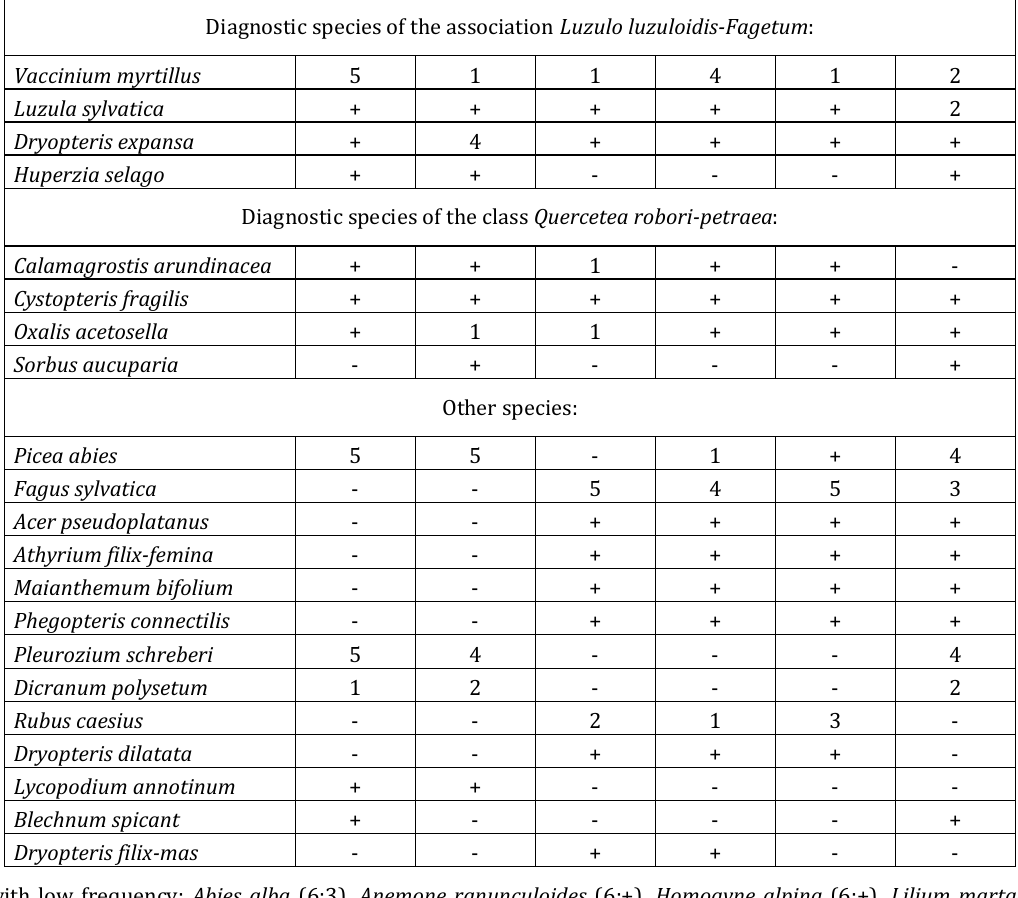
Species with low frequency: Abies alba (6:3), Anemone ranunculoides (6:+), Homogyne alpina (6:+), Lilium martagon (3:+), Polygonatum verticillatum (6:+), Prenanthes purpurea (6:+). Dates and locations of relevés: 1–2 – Synevyrske ERD, compartment 20, 26 Jul 2012; 3–5 – Kolochavske ERD, compartment